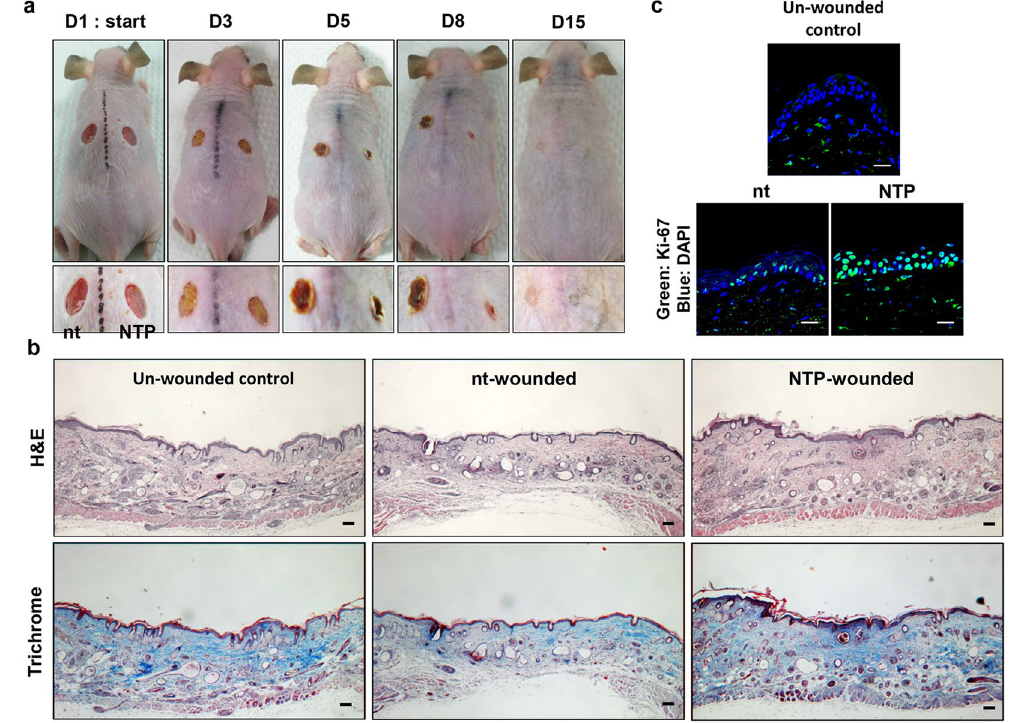
Figure 7. The effect of NTP on wound healing in mouse skin. ( a ) Two equal-sized wounds were created in the dorsal skin of HRM2 mice, as described in the Materials & Methods section. One of the wounds was subjected to NTP treatment for 5 minutes, three times per week, for 2 weeks. Over the course of the treatments, external changes in the wounds were monitored by taking photographs at the indicated time points. Data shown are representative of four independent experiments. ( b ) On day 15, the skin tissue of the wounds were isolated, and subjected to H&E and trichrome staining. Data shown are representative of four independent experiments, and photographs were taken at 40X magnitude. Scale bar: 100 μ m. ( c ) The results of IF assay against Ki-67 using the skin tissues. Scale bar: 20 μ